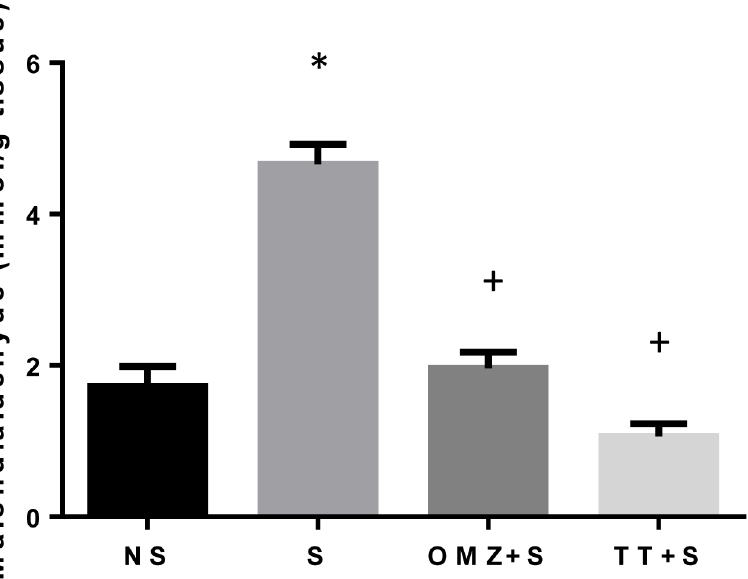
Fig 2. Effects of pre-treatment with tocotrienol (60 mg/kg BW) (TT) or omeprazole (20 mg/kg BW) (OMZ) on gastric malondialdehyde concentration in rats exposed to water immersion restraint stress (n = 7). * vs non-stressed control (NS) (P < 0.05). + vs stressed control (S) (P <